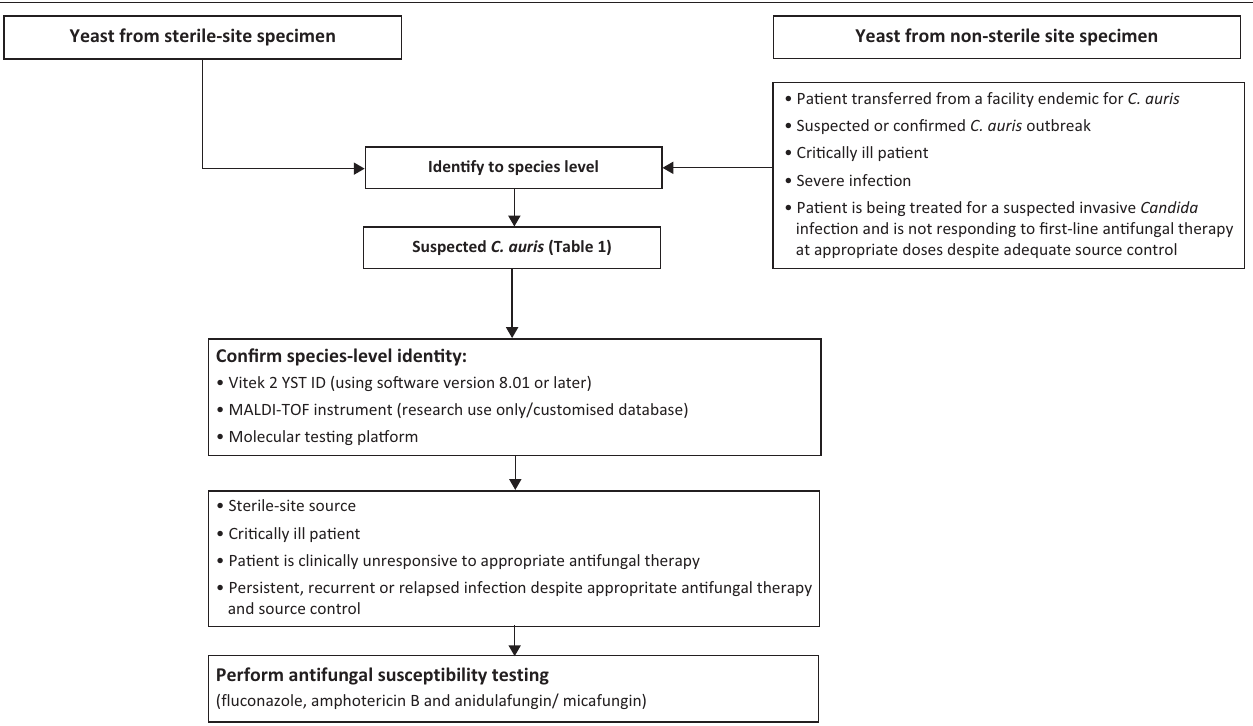
FIGURE 1: Laboratory testing algorithm for identification of Candia auris .